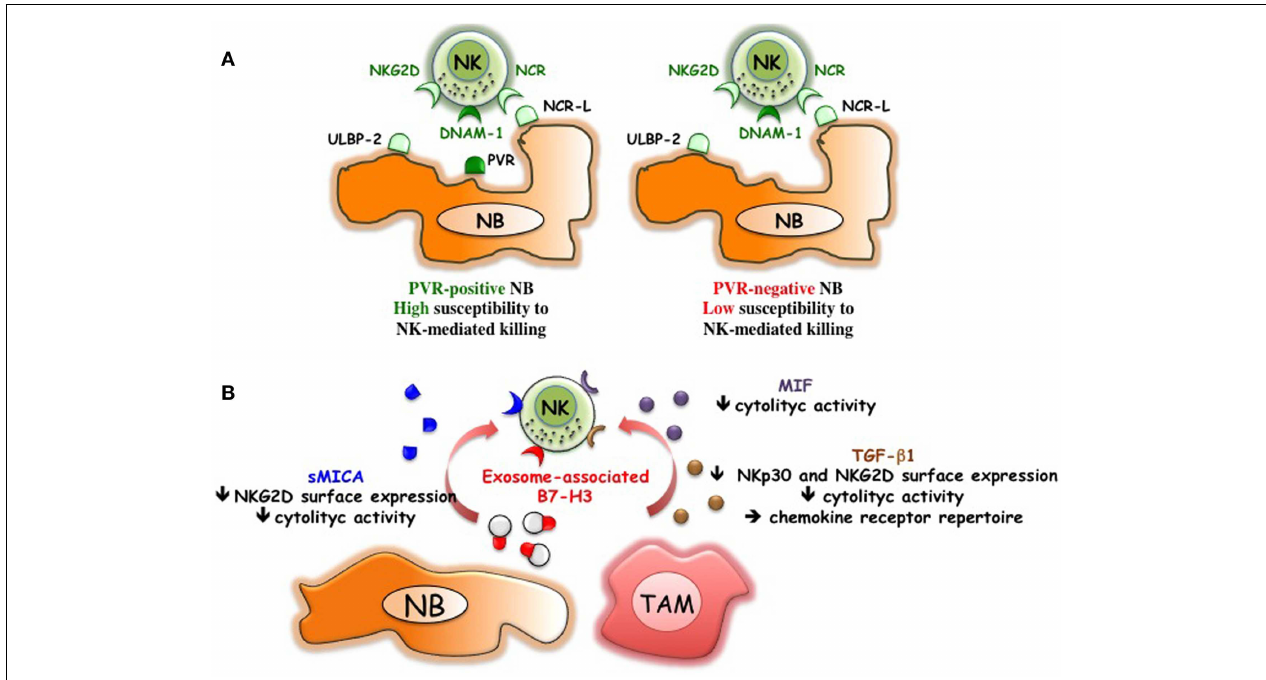
FIGURE 2 | NB-mediated mechanisms of escape from the NK-mediated immunosurveillance . (A) Downregulation of PVR, ligand of DNAM-1 activating receptor, renders NB cells poorly susceptible to NK-mediated killing. (B) NB can release soluble MICA, exosome-associated B7-H3, immunomodulatory factors such as MIF andTGF- β 1.TGF- β 1 might be also released by tumor-associated macrophages (TAM) that display M2-like functional